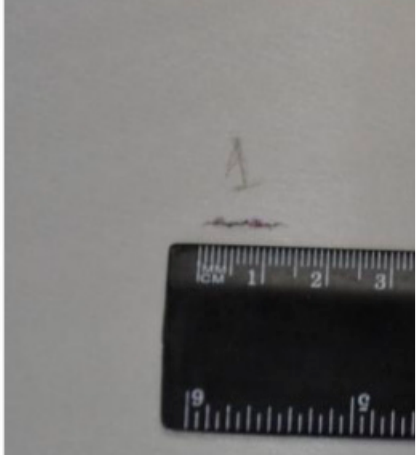
Figure 5. Actual defect and calculation grid for a defect on a disc segment.